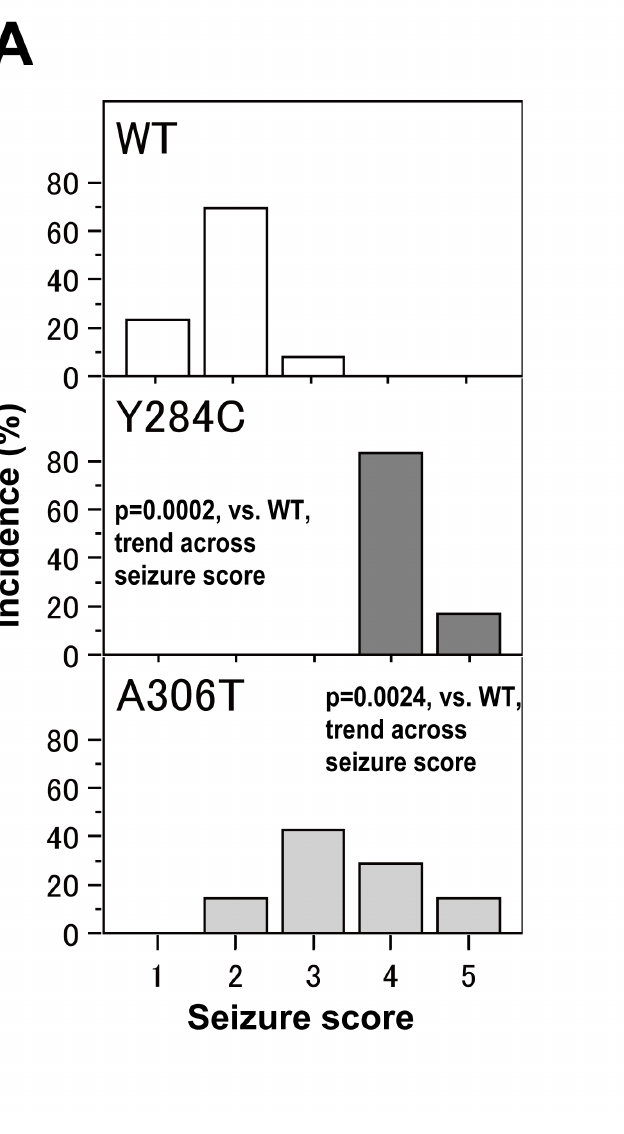
Fig 3. Relationship between heterozygous Kcnq2 mutations and seizures. A. The distribution of seizure scores in WT mice (n = 13) (upper panel, in white color), Kcnq2 Y284C/+ mice (n = 6) (middle panel, in gray color), and Kcnq2 A306T /+ mice (n = 7) (lower panel, in light gray color). Differences in the distribution of seizure scores among and between groups were examined by the logistic regression analysis, as described in the Methods. B and C . Box-and- whisker plots showing the mean ( ● ), median (middle bar in the rectangle), and 10 th (bottom bar), 25 th (bottom of rectangle), 75 th (top of rectangle), and 90 th (top bar) percentiles of the number (B) and duration (C) of spike bursts in WT (n = 13) (in white color), Kcnq2 Y284C/+ (n = 6) (in gray color), and Kcnq2 A306T /+ (n = 7) mice (in light gray color). The number and duration of spike bursts were compared among and between groups by using Negative binomial model, as described in the Methods. Raw data for bar and box plots are included in S1